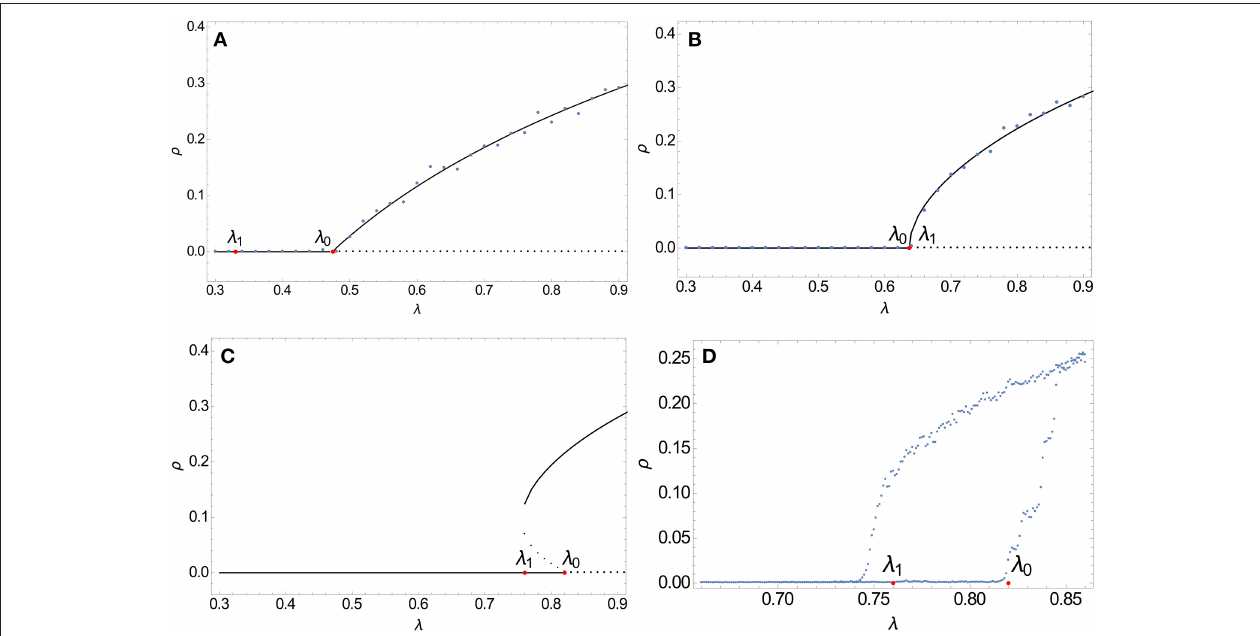
FIGURE 1 | Complete solutions of Equation (7) are shown in black for T = 3, k = 10, and a = 1.2,1.53,1.8 ( A–C , respectively). Continuous lines represent stable solutions. Note that when λ 0 intersects the upper branch, the transition is continuous (A) . When λ 0 intersects the lower branch (C) , two stable solutions coexist in the region λ 1 < λ < λ 0 , 0 and ρ up , and the transition is discontinuous. Simulations of the microscopic model are shown in blue points in (A,B) . For (C) the simulation is shown in (D) , that amplifies the region λ 1 − λ 0 , showing the hysteresis of the system. (B) illustrates the case when λ 0 = λ 1 .